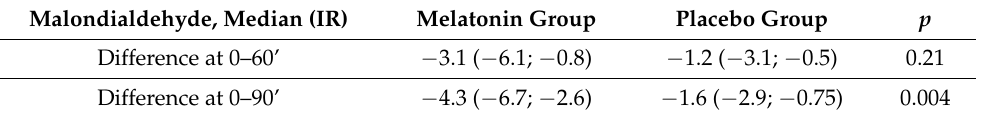
Table 4. Quantification of MDA from baseline level, at 60’ and 90’ after melatonin/placebo adminis- tration, and differences in concentration between 0–60’ and 0–90’ in cDCD (controlled Donation After Circulatory Death). IR, Interquartile